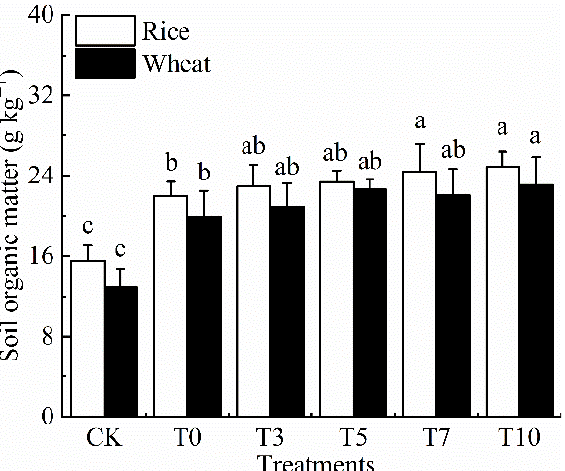
Figure 4. Effect of different fertilization treatments on soil organic matter content. Columns with different small case letters show significant difference between different treatments at p < 0.05 by LSD’s multiple range test. Values are mean of four replicates and bars show standard deviation. CK, no nitrogen fertilizer applied; T0, 100% conventional urea (CU); T3, one-time basal application of slow-release urea (SRU) and CU mixture with 30% SRU; T5, one-time basal application of SRU and CU mixture with 50% SRU; T7, one-time basal application of SRU and CU mixture with 70% SRU; T10, one-time basal application of 100% SRU.